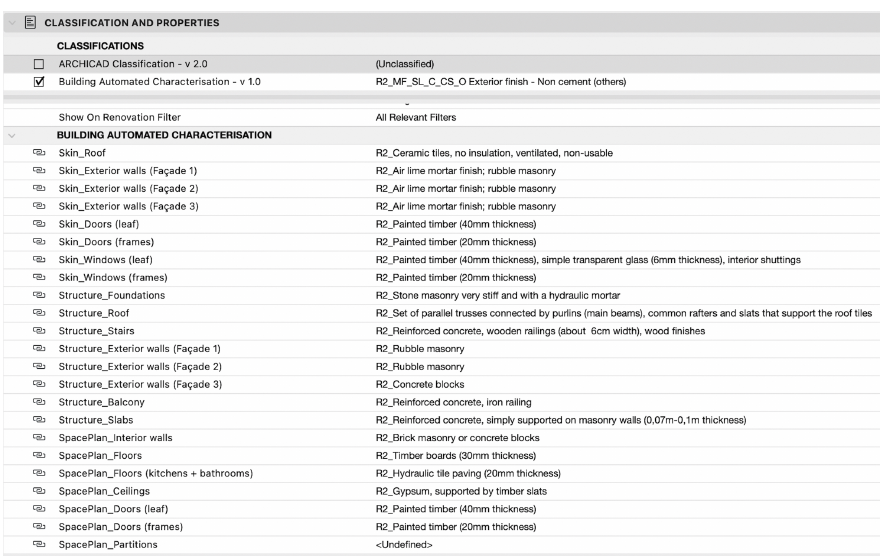
Figure 7. BAC – construction system characterisation.